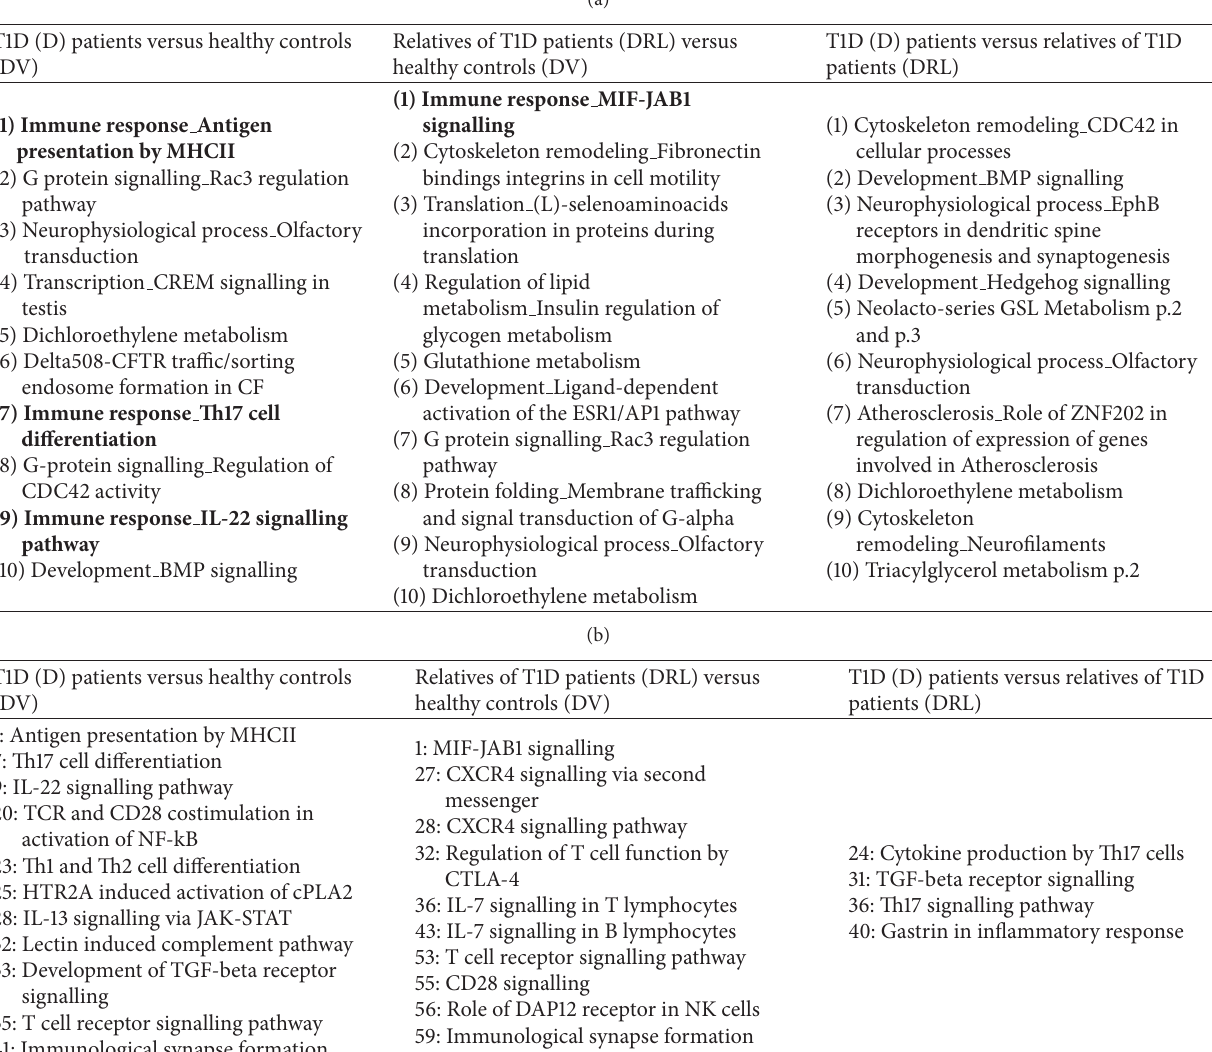
Table 3: (a) GeneGo pathway top 10 maps (“immune response pathways” are in bold). (b) The complete list of significant “immune response pathways” for each pair comparison; pathway rankings (the position of each pathway within the list) are